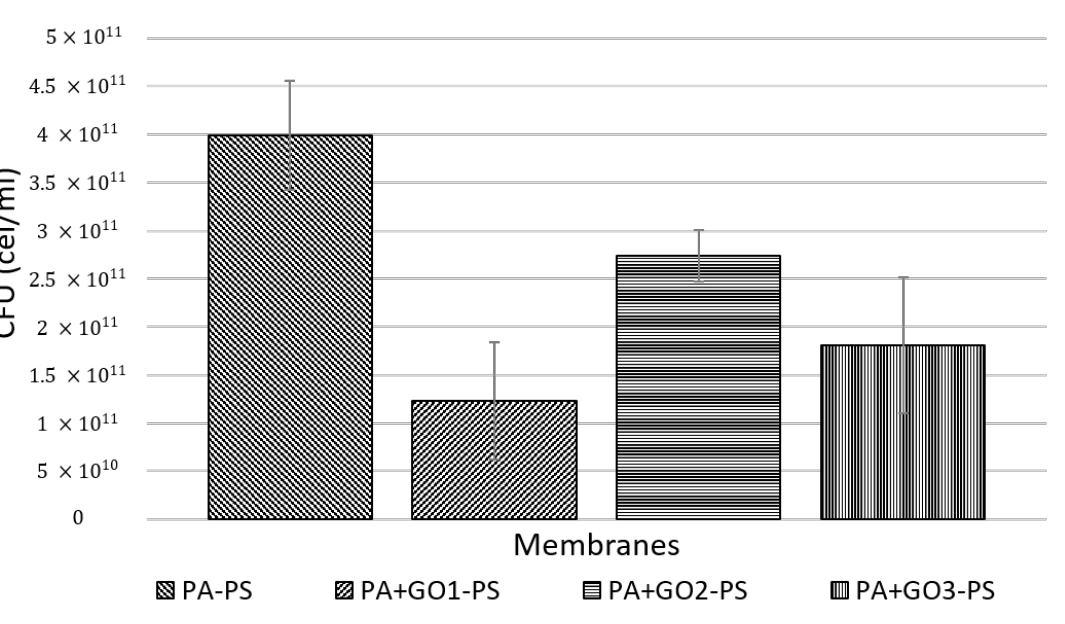
Figure 7. Bactericidal effect of the membranes on Escherichia coli . Table 5. Anti-biofouling effect of membranes.